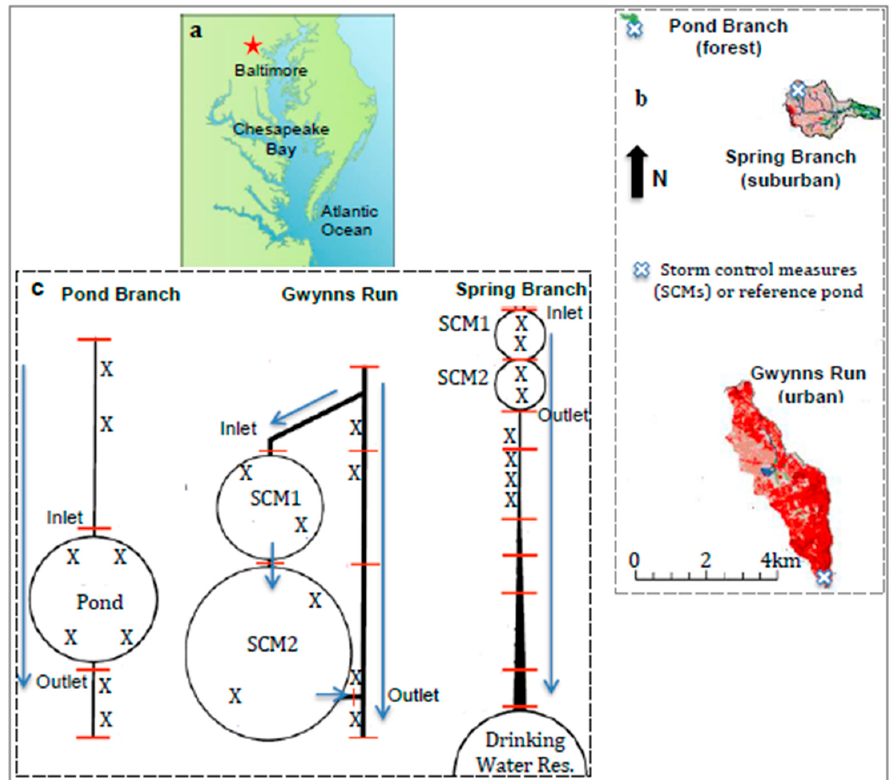
Figure 1. ( a ) Location of LTER site; ( b ) land use of study watersheds; and ( c ) conceptual diagram of stream water and groundwater sampling in the Spring Branch, Gwynns Run, and Pond Branch watersheds. Green, pink and red colors in ( b ) represent forest, suburban and urban land use, respectively, and the positions of these sites are in relationship to one another. Red lines in ( c ) indicate locations of monthly surface water chemistry and discharge measurements. “X”s indicate locations of mini-piezometer wells used for seasonal groundwater monitoring. Arrows indicate flow direction. Pond in Pond Branch and SCMs in Spring Branch are inline while SCMs in Gwynns Run are oxbow type.